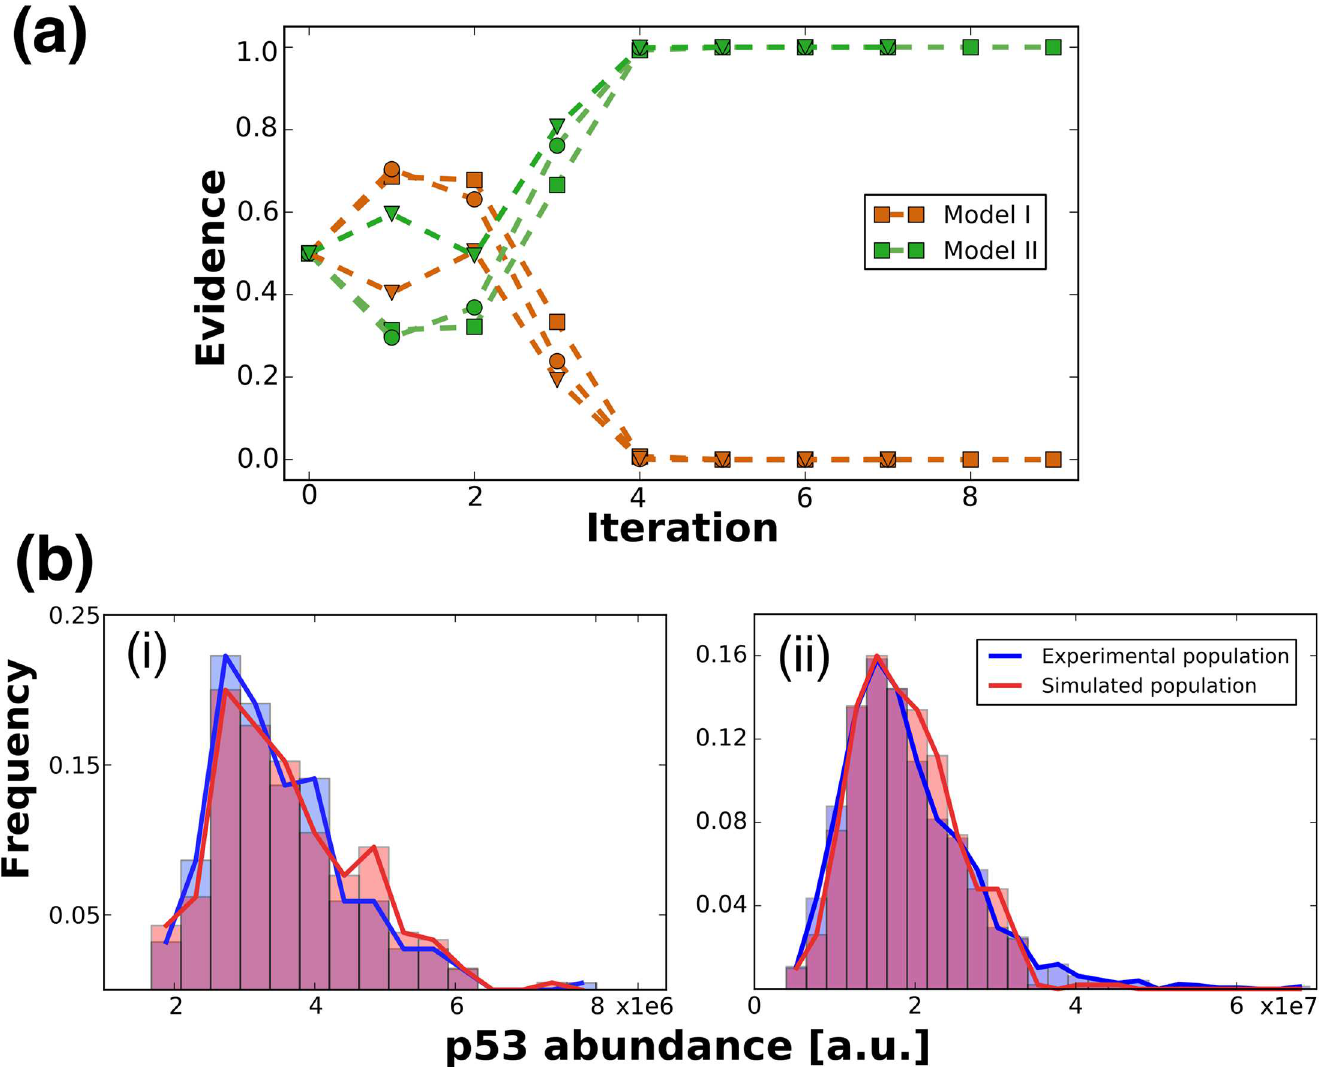
Fig 3. Results of computational analysis. (A) Result of iterative model selectionalgorithm. Evidencerepresents what ratio of acceptedfits was obtained from a certain model. Dark orangeand green curves show the transcription- (ModelI) and the degradation-based (ModelII) models, different markers denotereplicates with different prior parameter distributions used at initialisingthe algorithm. (B) Comparison of experimental and simulateddistributions. Histograms and solid curves outline the distributionof p53 abundance(measured as arbitrary fluorescence units) in (i) MCF7 and (ii) BE cells. Blue distributions were measured experimentally, red distributionswere simulatedduringinferenceusing the best fitting parameter combination. Note the difference in scale of p53 abundance in both histograms. α values of the fits: (i) α = 0.59, (ii) α = 0.34.